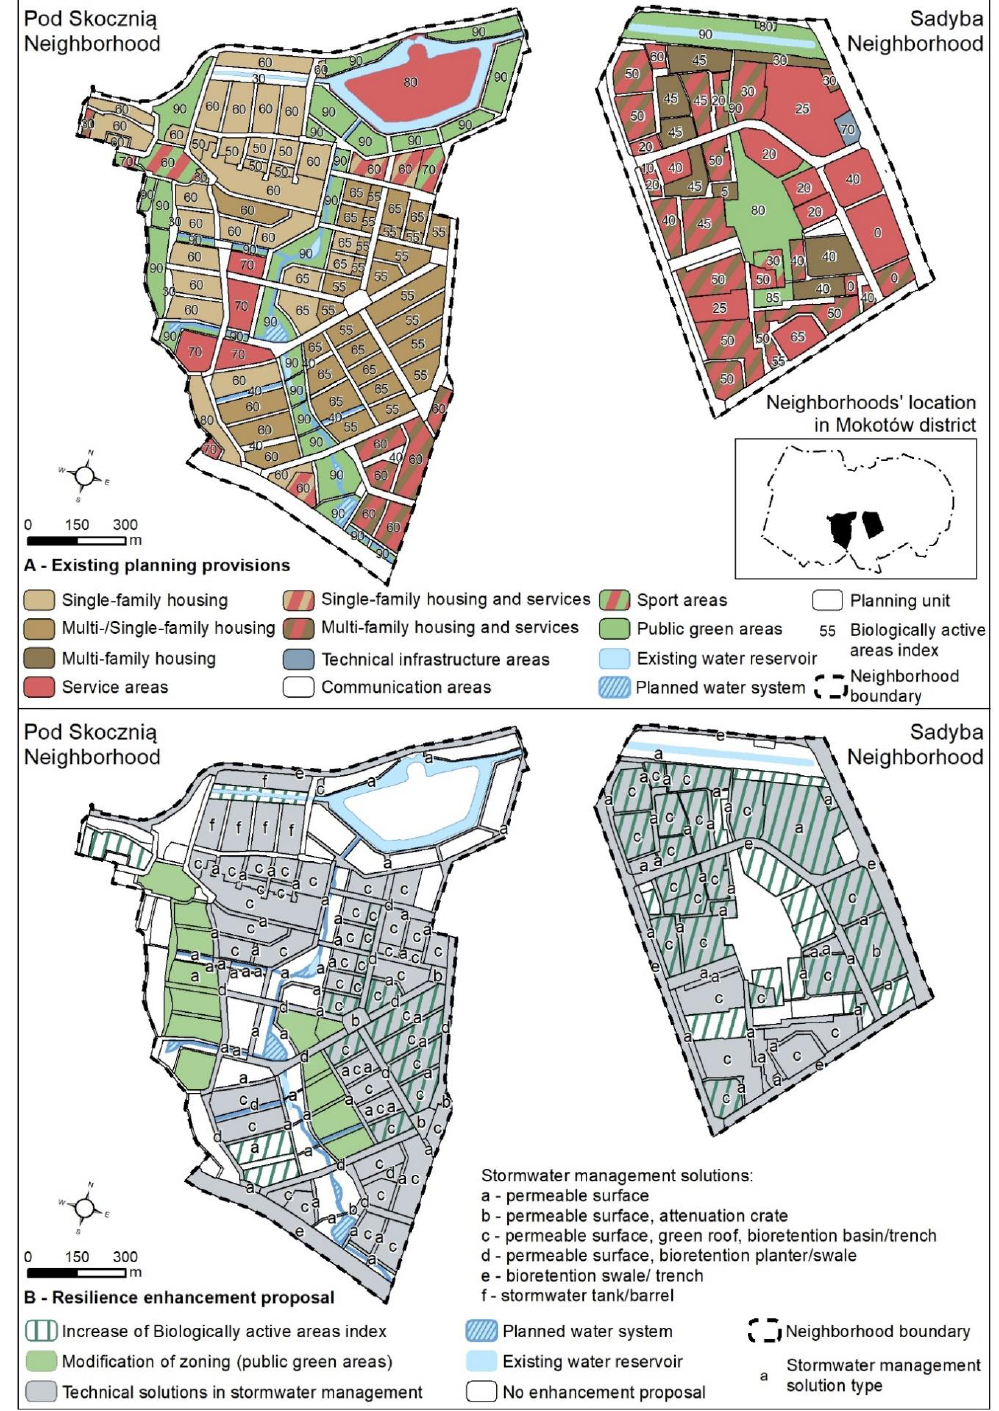
Figure 3. ( A ) Existing planning provisions in case studies, ( B ) Resilience enhancement